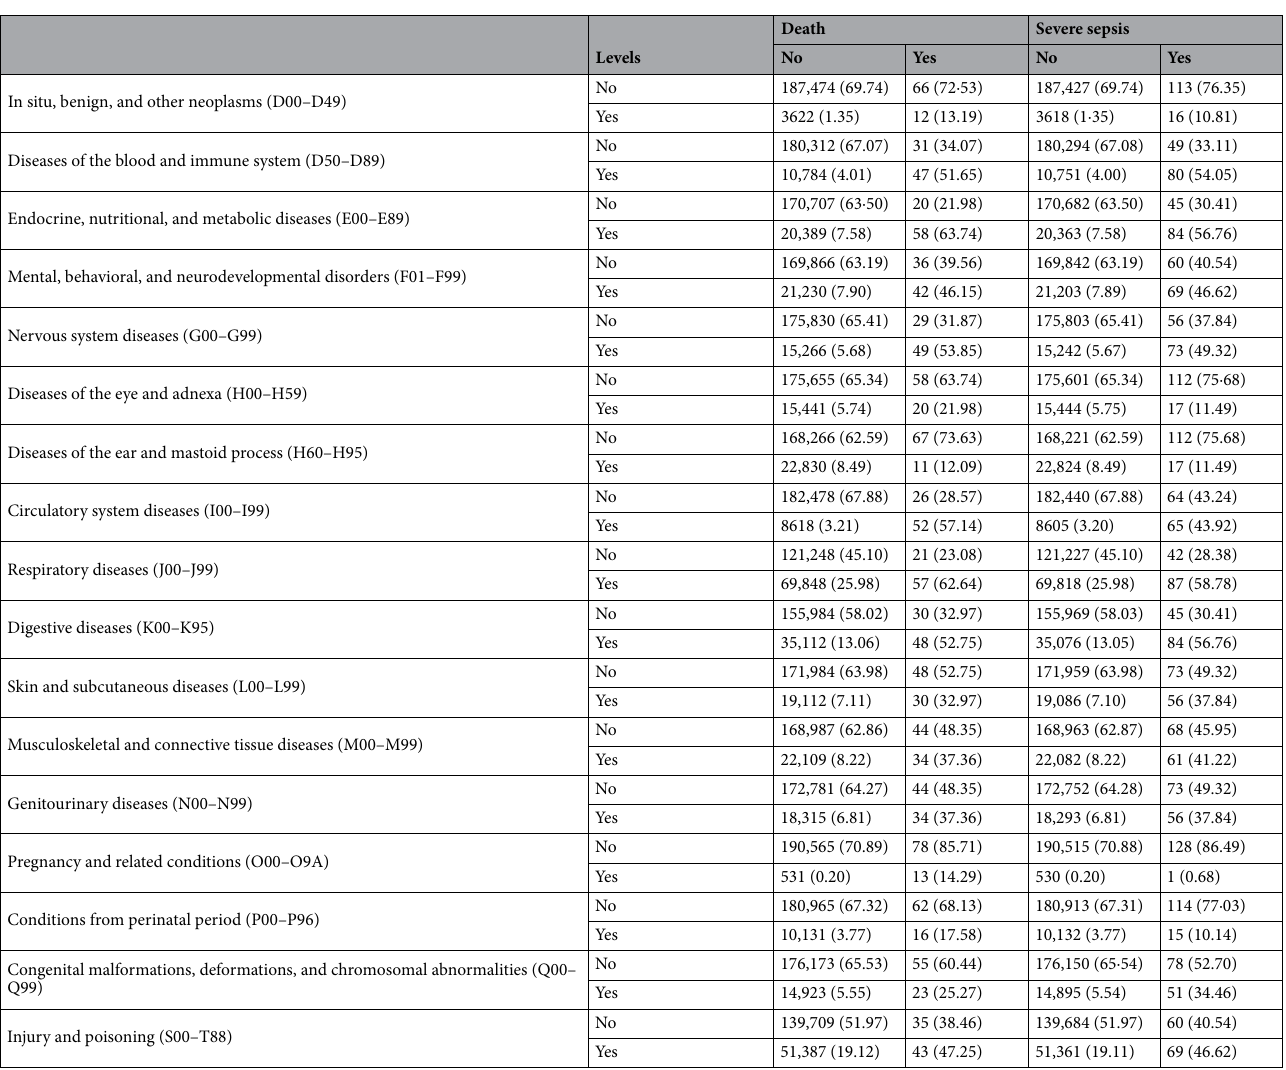
Table 1. Summary statistics: death and severe